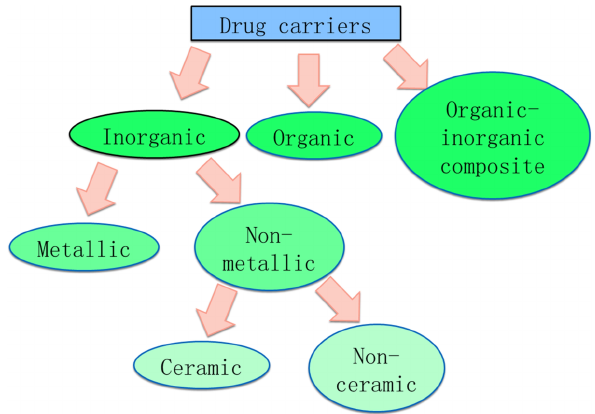
Figure 1: Classification of drug carriers